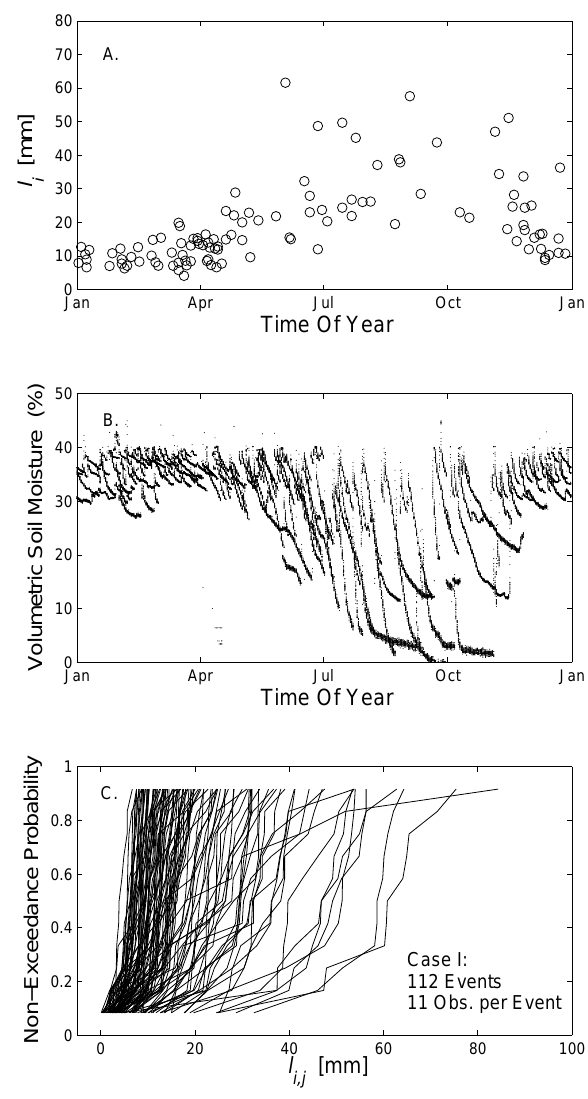
Fig. 2. Plot A shows water-loss depths at the basin scale, l i , for 112 events versus time of year. Plot B shows volumetric soil moisture content versus time of year from Furey and Gupta (2005). Plot C shows empirical CDFs of water-loss depths at the unnested basin scale, l i,j , for 112 events. Each distribution represents a rainfall–runoff event.